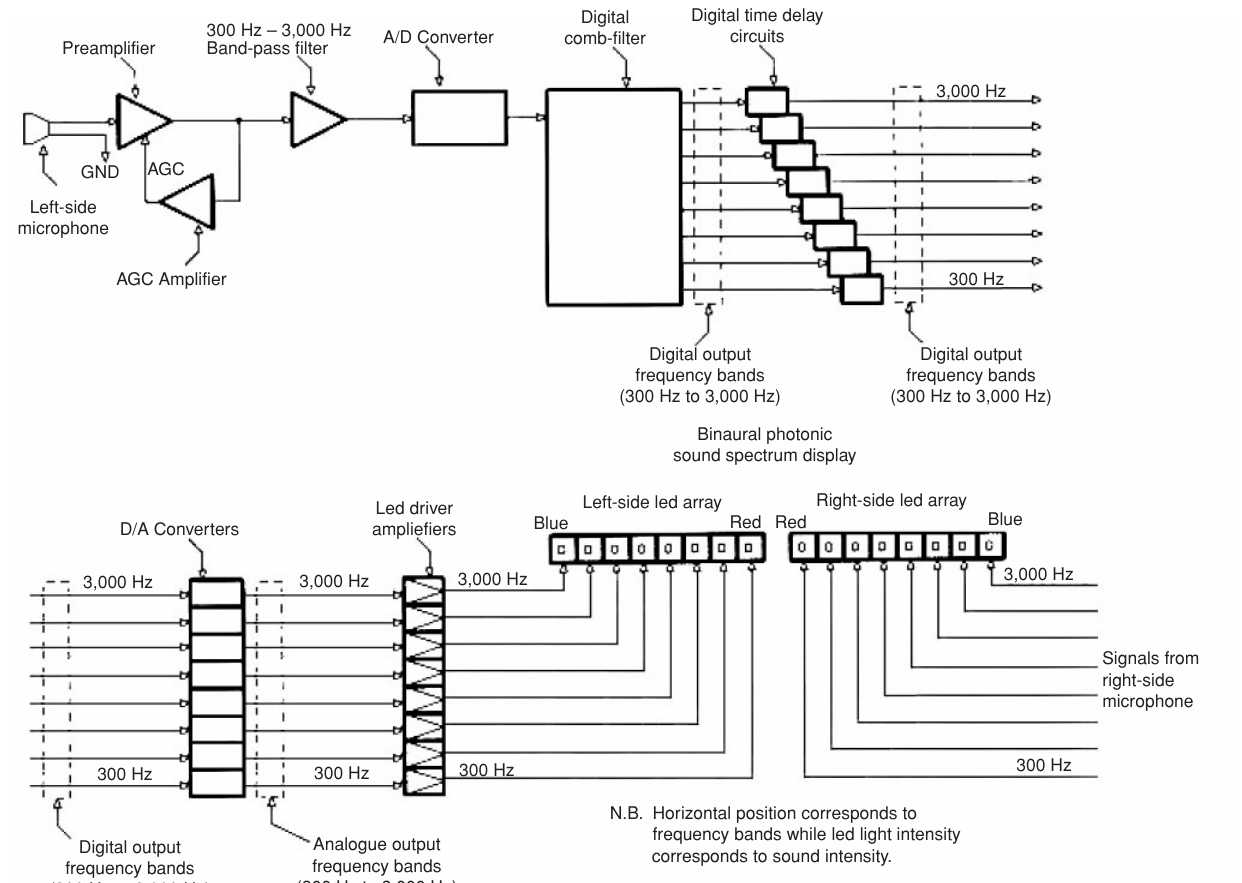
Figure 1 Photonic hearing